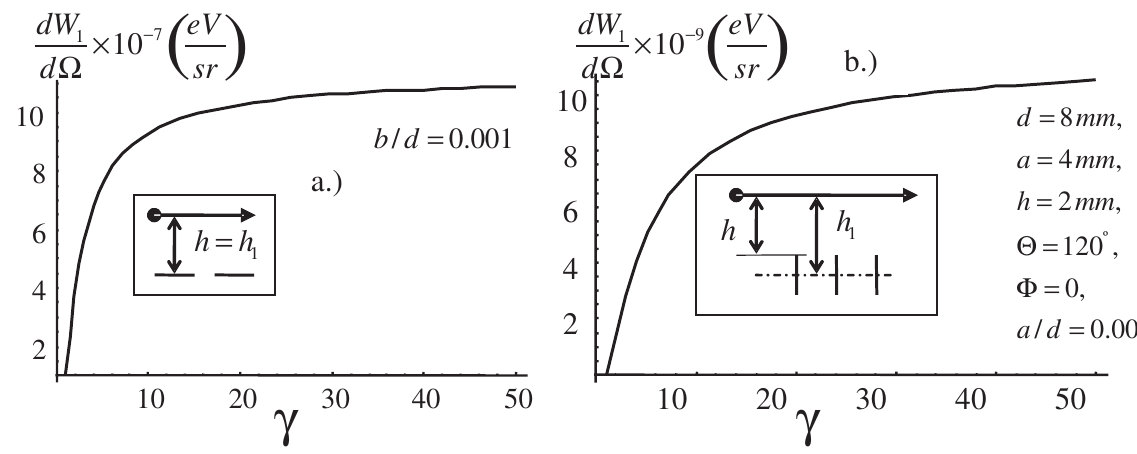
FIG. 12. Dependence of the SPR intensity on the Lorentz factor according to the RDR model: (a) for a flat grating; (b) for a vertical strip